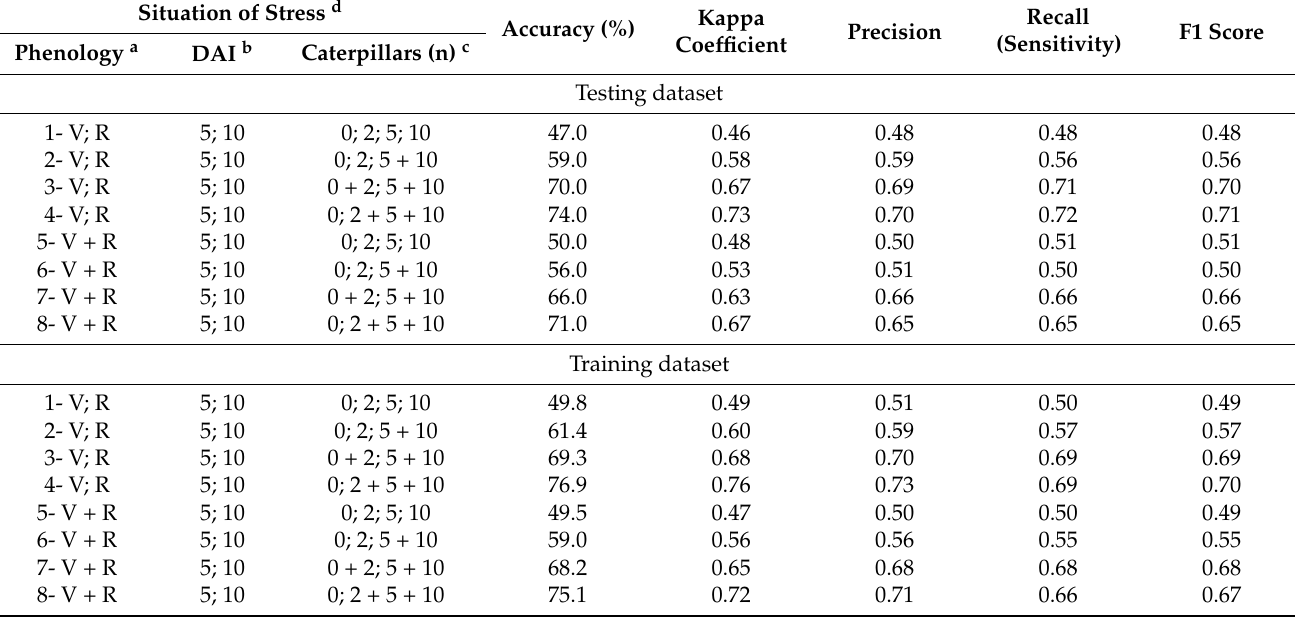
Table 3. Results for accuracy, Kappa coefficient, precision, recall, and F1 score for the testing and training datasets for discrimination of soybean plants under different situations of stress caused by C. includens and S. eridania based on multilayer perceptron artificial neural networks. Situation of Stress d Recall Kappa Accuracy (%) Precision F1 Score (Sensitivity) Coefficient Phenology